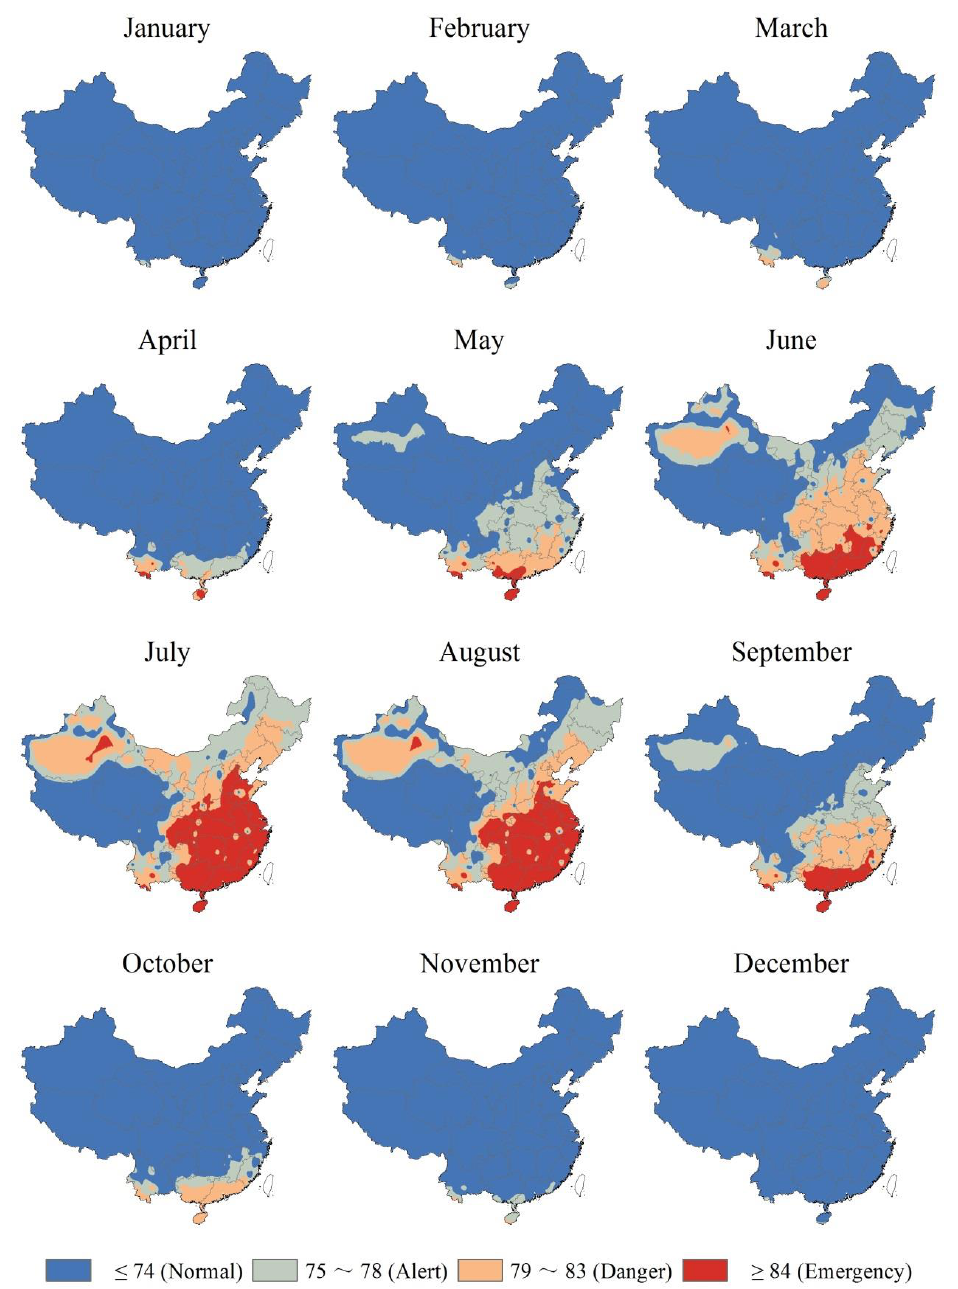
Figure 2. Classified monthly mean THI maps for January to December.